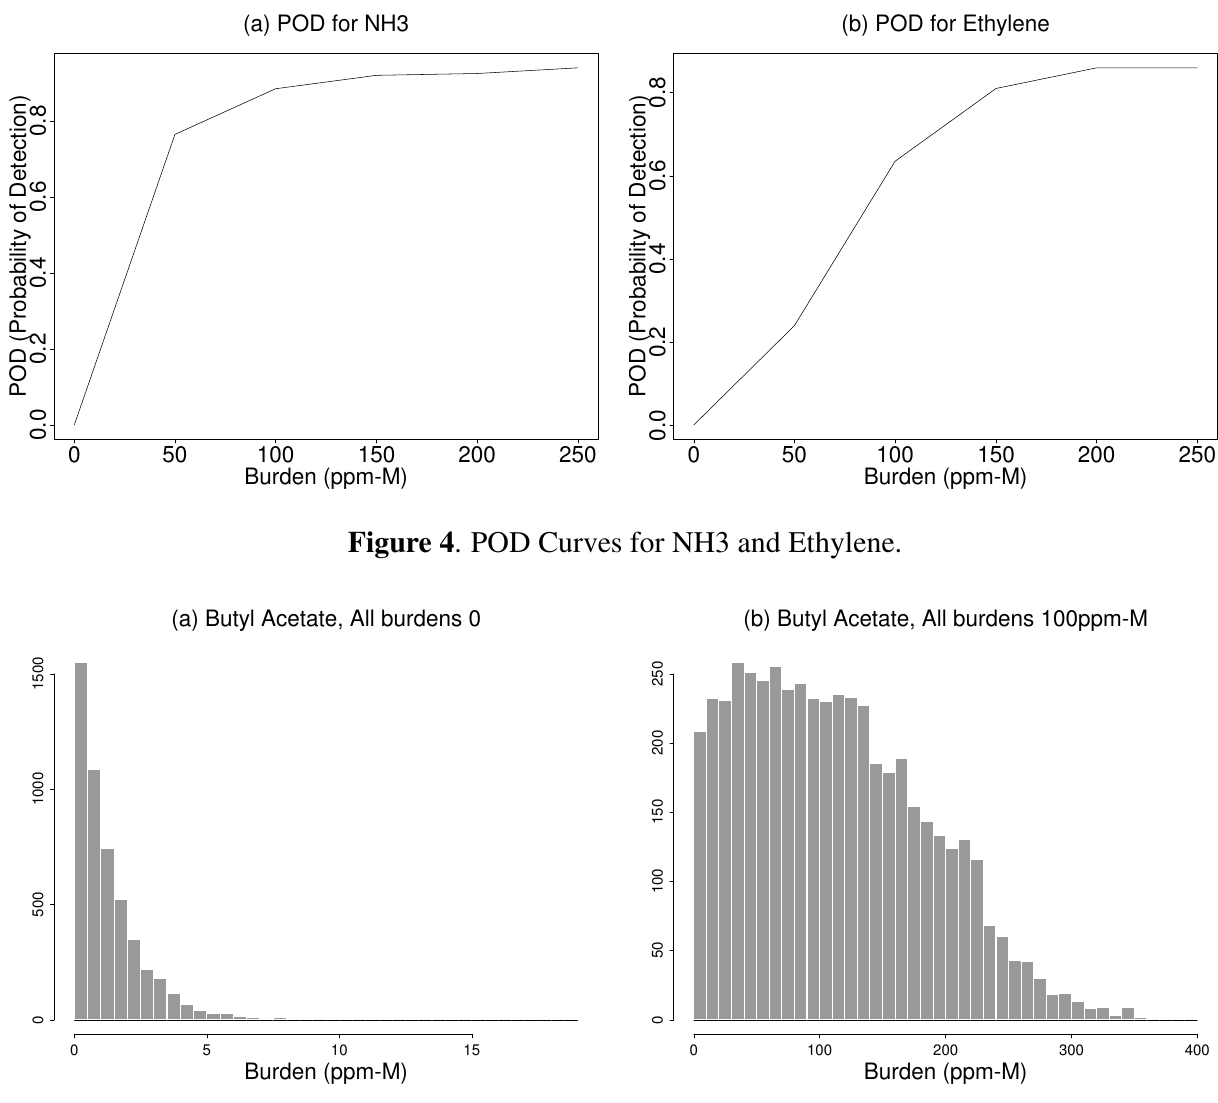
Figure 5 . MCMC Derived Posterior for a Plume with 11 Highly Correlated